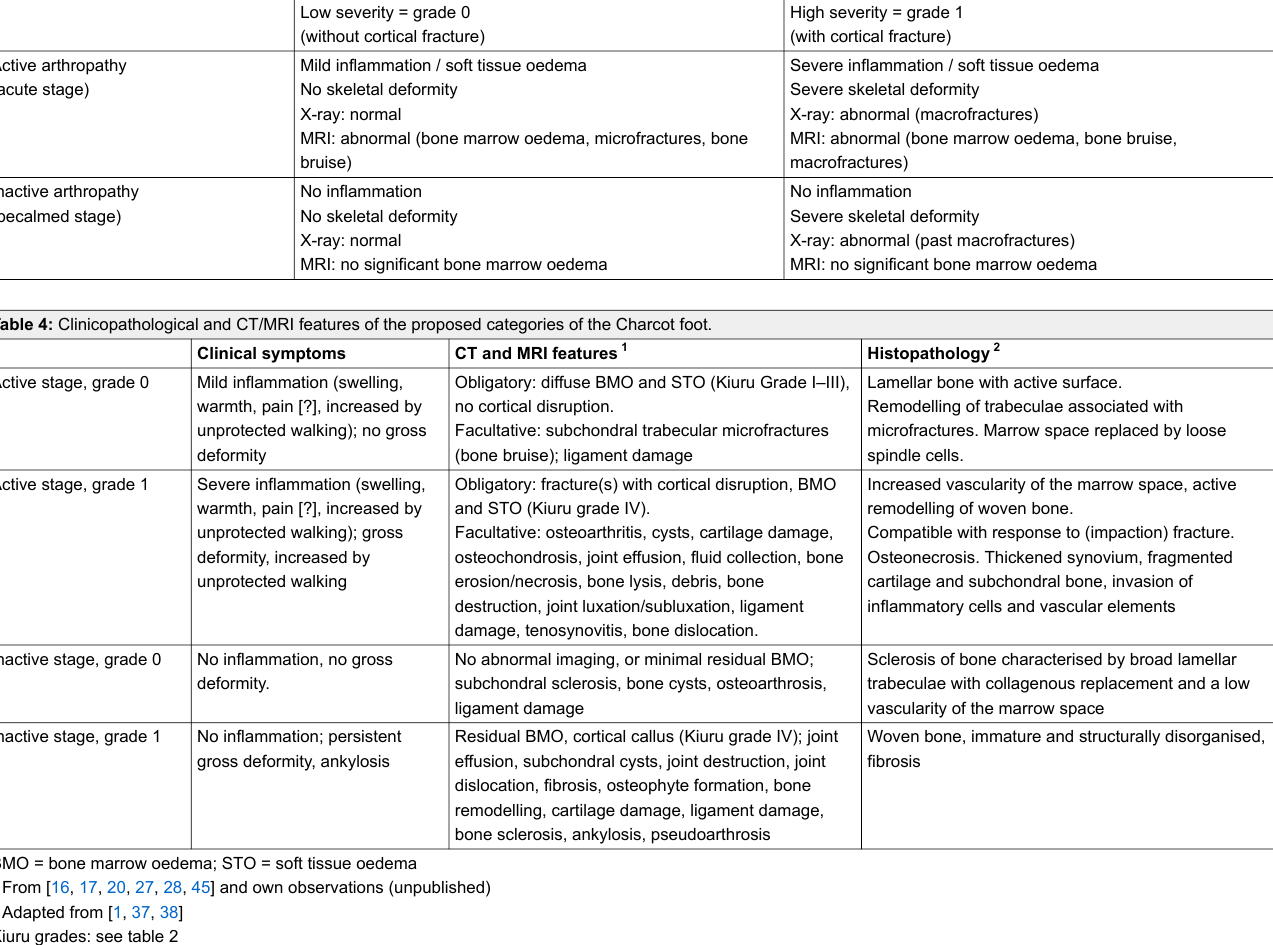
Table 3: Categories of Charcot’s arthropathy of the foot (Charcot foot), based on magnetic resonance imaging (MRI). Severity gradeStage